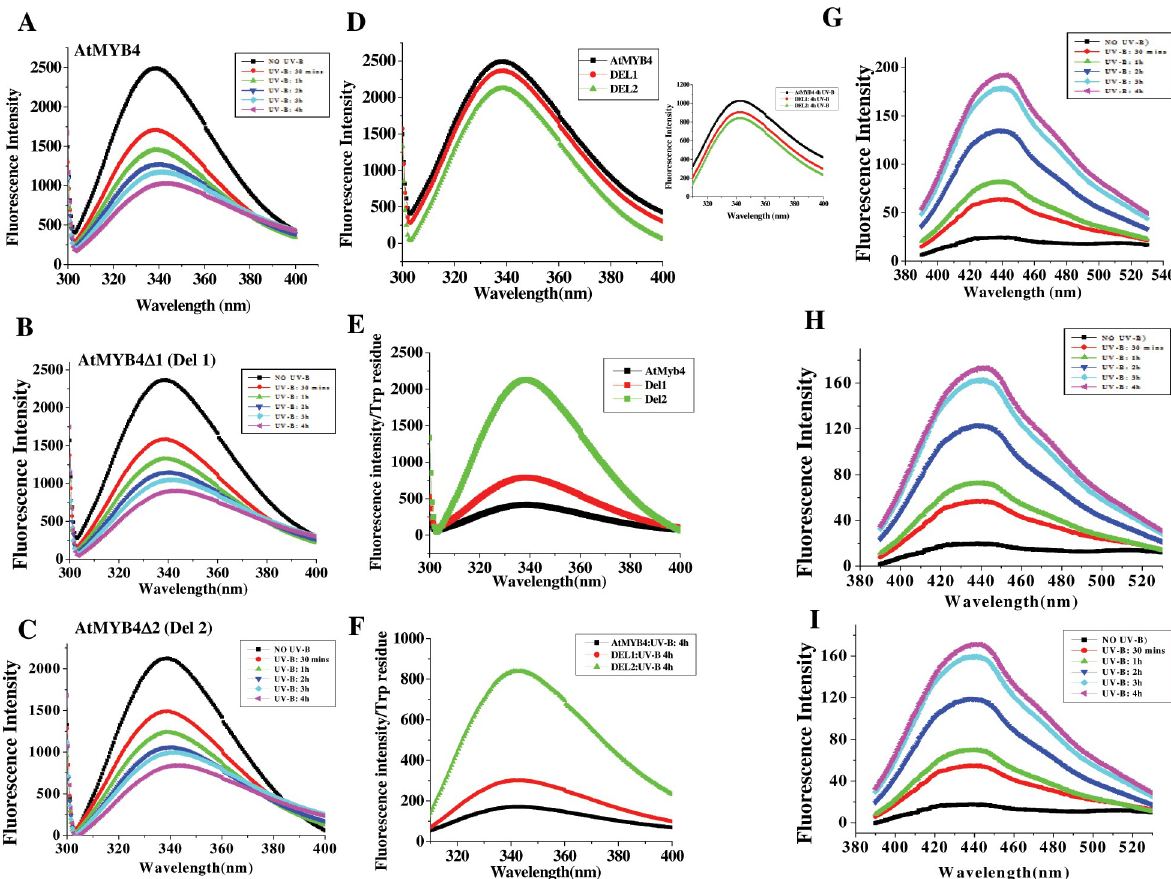
Fig 3. Tryptophan fluorescence spectra of untreated control and UV-B irradiated purified recombinant AtMYB4, AtMYB4 Δ 1 and AtMYB4 Δ 2 proteins. About 0.05 mg/ml of purified recombinant AtMYB4 (A), AtMYB4 Δ 1 (B) and AtMYB4 Δ 2 (C) protein samples in a final volume of 500 μ L of 50 mM Tris-HCl buffer, pH 7.5 (containing 1 mM β -ME and 1 mM PMSF) were irradiated with an UV-B dose of ~200 J/m 2 for the indicated time points in the dark at 25˚C. Tryptophan fluorescence spectra of control and UV-B irradiated protein samples were measured by following the procedure described under ‘Materials and Methods’. The 0-h time point served as the control. (D) Tryptophan fluorescence spectra of untreated control and 4 h UV-B treated (embedded image) AtMYB4, AtMYB4 Δ 1 and AtMYB4 Δ 2 proteins. E and F. Normalized tryptophan fluorescence spectra (per tryptophan residue) of untreated control (E) and UV-B exposed (~200 J/m 2 for 4 h) AtMYB4, AtMYB4 Δ 1 and AtMYB4 Δ 2 proteins (F). G-I. UV-B mediated oxidative degradation of tryptophan residues to N-formylkynurenine in AtMYB4 (G), AtMYB4 Δ 1 (H) and AtMYB4 Δ 2 (I) proteins following UV-B exposure for various time points. Fluorescence spectra were measured using excitation wavelength of 365 nm with the emission wavelengths ranging from 390 to 530 nm and emission scan speed of 240 nm/min, using 0.05 mg/ml of purified protein samples.